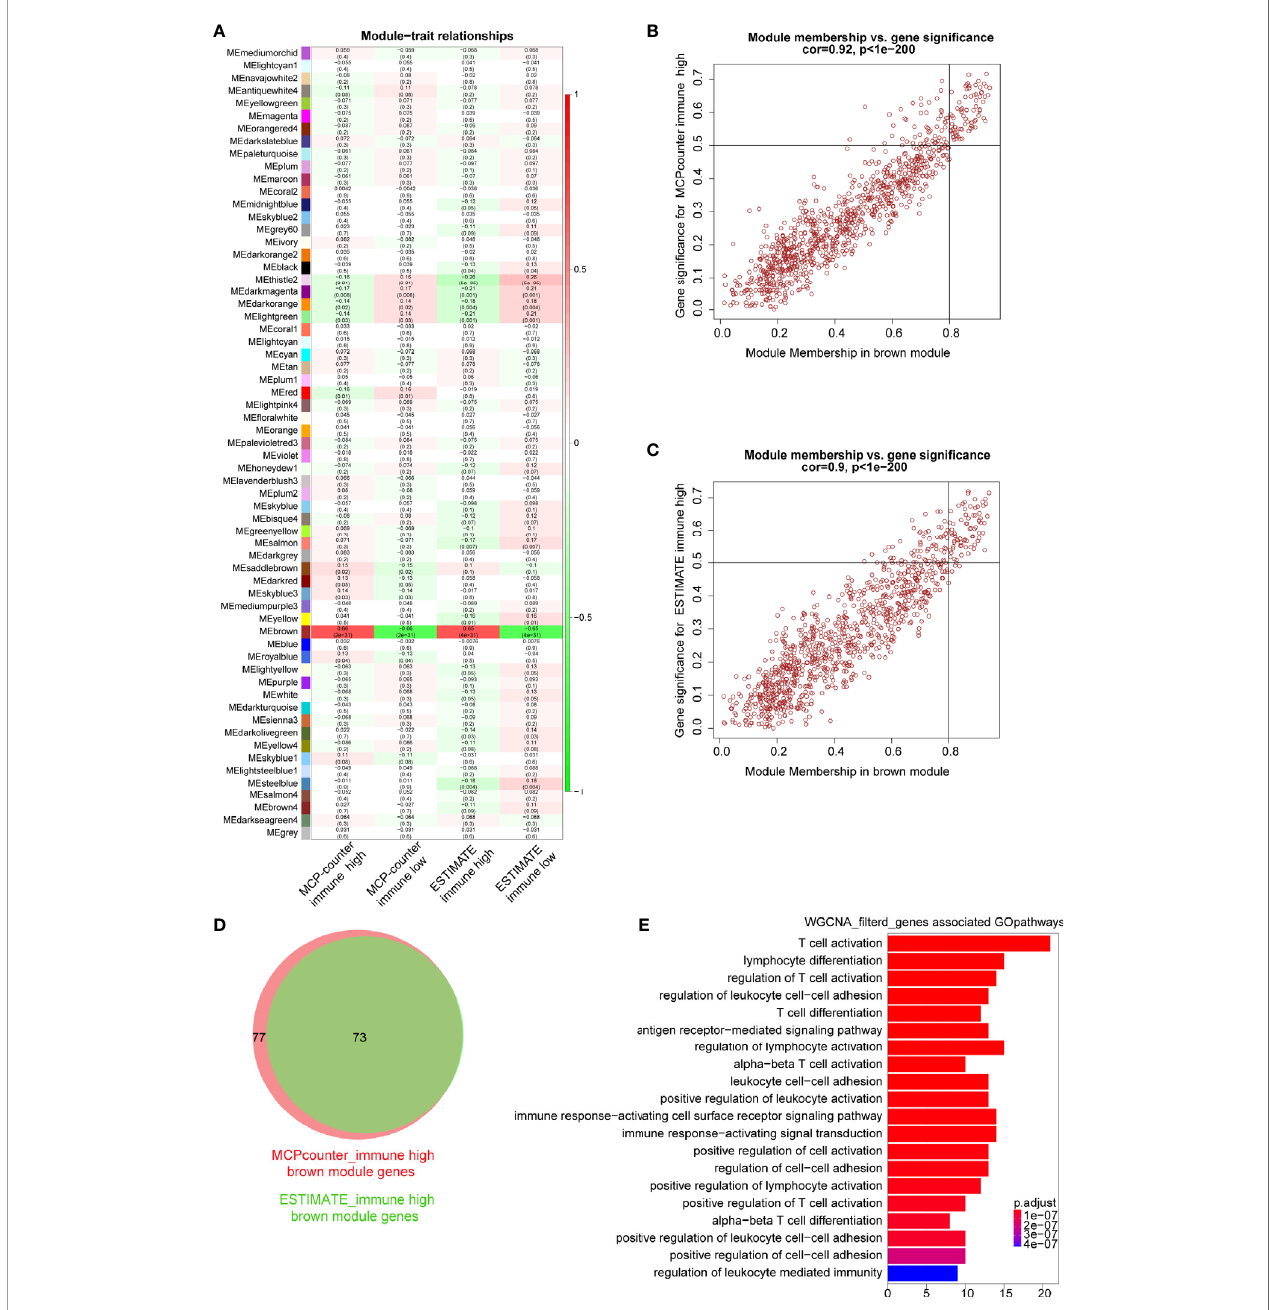
FIGURE 3 | Key modules and genes identi fi ed based on module – trait relationship. (A) The relationship between co-expression modules and traits; each grid includes the degree of correlation and P -value. (B, C) Scatter plots showing the relationship of module membership (MM) in brown module, with gene signi fi cance (GS) for high-immune in fi ltration determined by the MCP-counter and ESTIMTE algorithms, for which MM >0.8 and GS >0.5 were set as gene fi ltered standard, respectively. (D) Venn plot showing common fi ltered genes identi fi ed in the high-immune in fi ltration groups determined by the MCP-counter and ESTIMATE. (E) GO analysis for WGCNA fi ltered genes in the biological